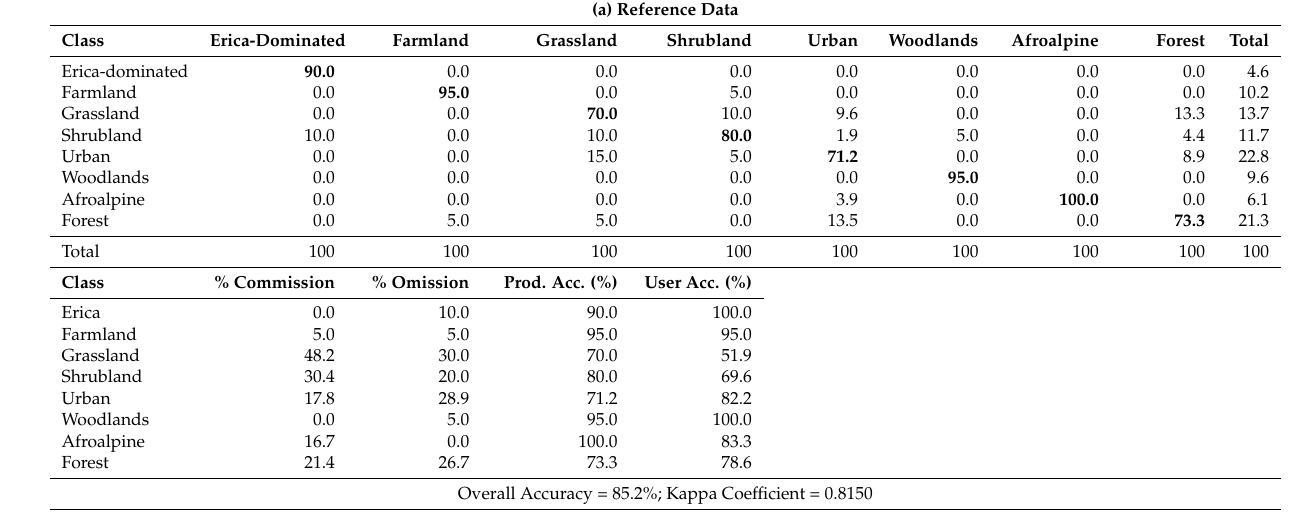
Table 2. Error matrix with derived errors and accuracies for the years 1985 ( a ) and 2015 ( b ) in